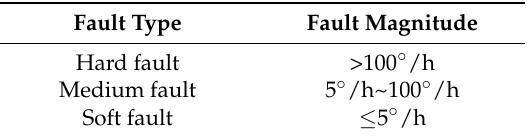
Table 1. Categories and amplitudes of